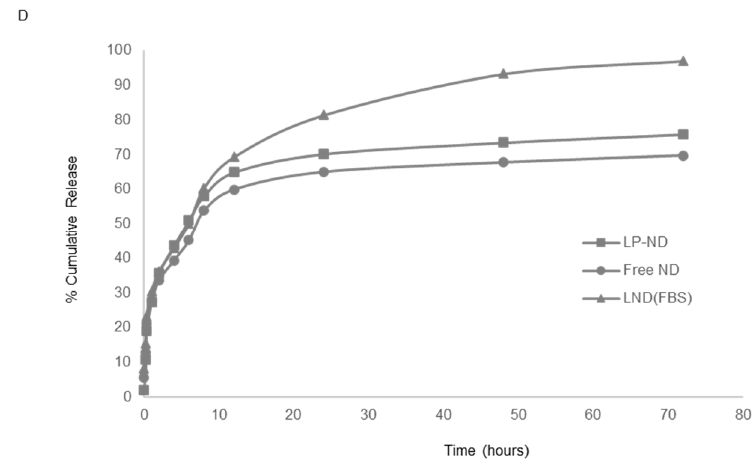
Figure 1. Liposome preparation and characterization. ( A ) Liposome characterization. ( B ) Size distribution plots as obtained at a scan rate of 140 counts per second at 25 °C. Top panel is for nonloaded liposomes while the bottom panel is for nedaplatin ‐ loaded liposomes. ( C ) TEM image for LND formulation showing uniform spherical structures. The coating PEG layers are also shown as lighter outer circles (see arrow). ( D ) Nedaplatin and formulated nedaplatin release profiles in PBS and FBS media. Circles represent free nedaplatin in PBS, squares are liposomal nedaplatin in PBS and triangles represent liposomal nedaplatin in FBS.